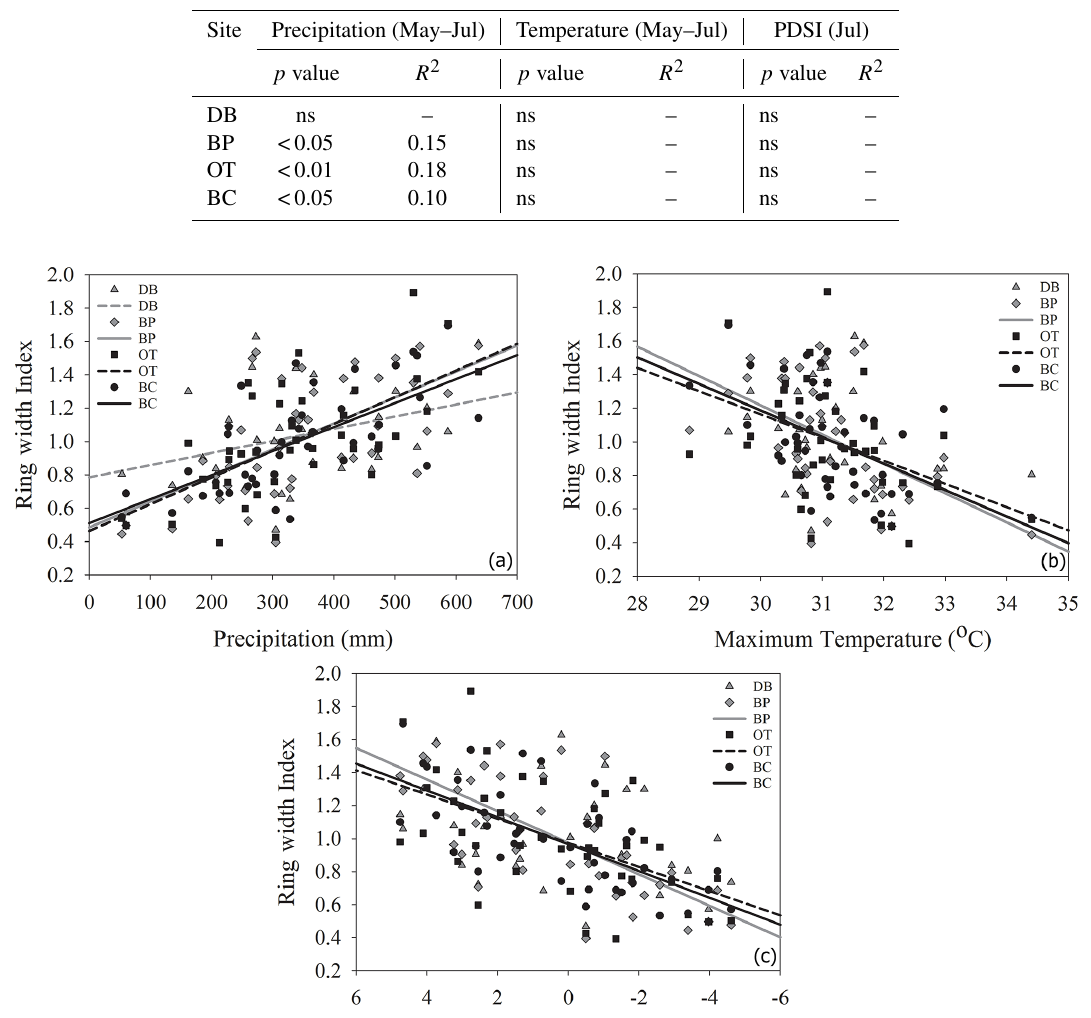
Table 7. Relationships between basal area increment and midgrowing season climatic conditions ( α = 0 . 05).